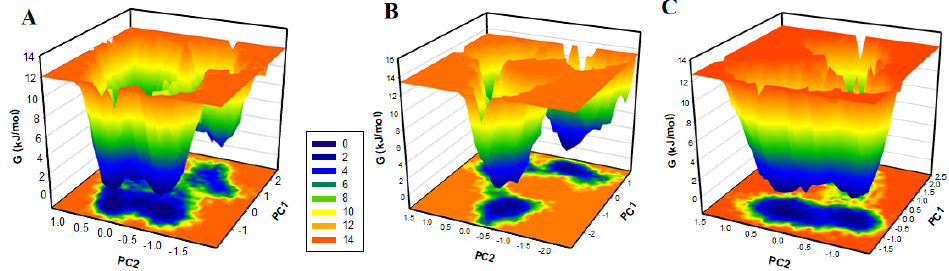
Figure 8. The free energy landscapes of ( A ) free YES1, ( B ) YES1-Glabrene, and ( C )